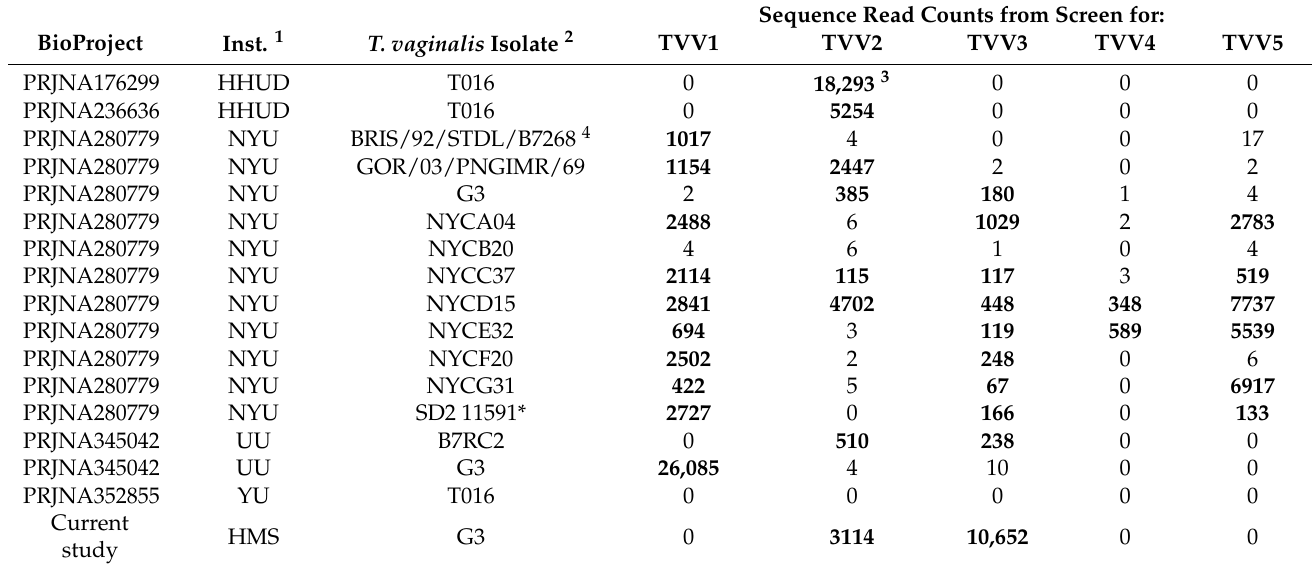
Table 1. Screens of SRA datasets at NCBI for TVV-matching sequence reads. Sequence Read Counts from Screen